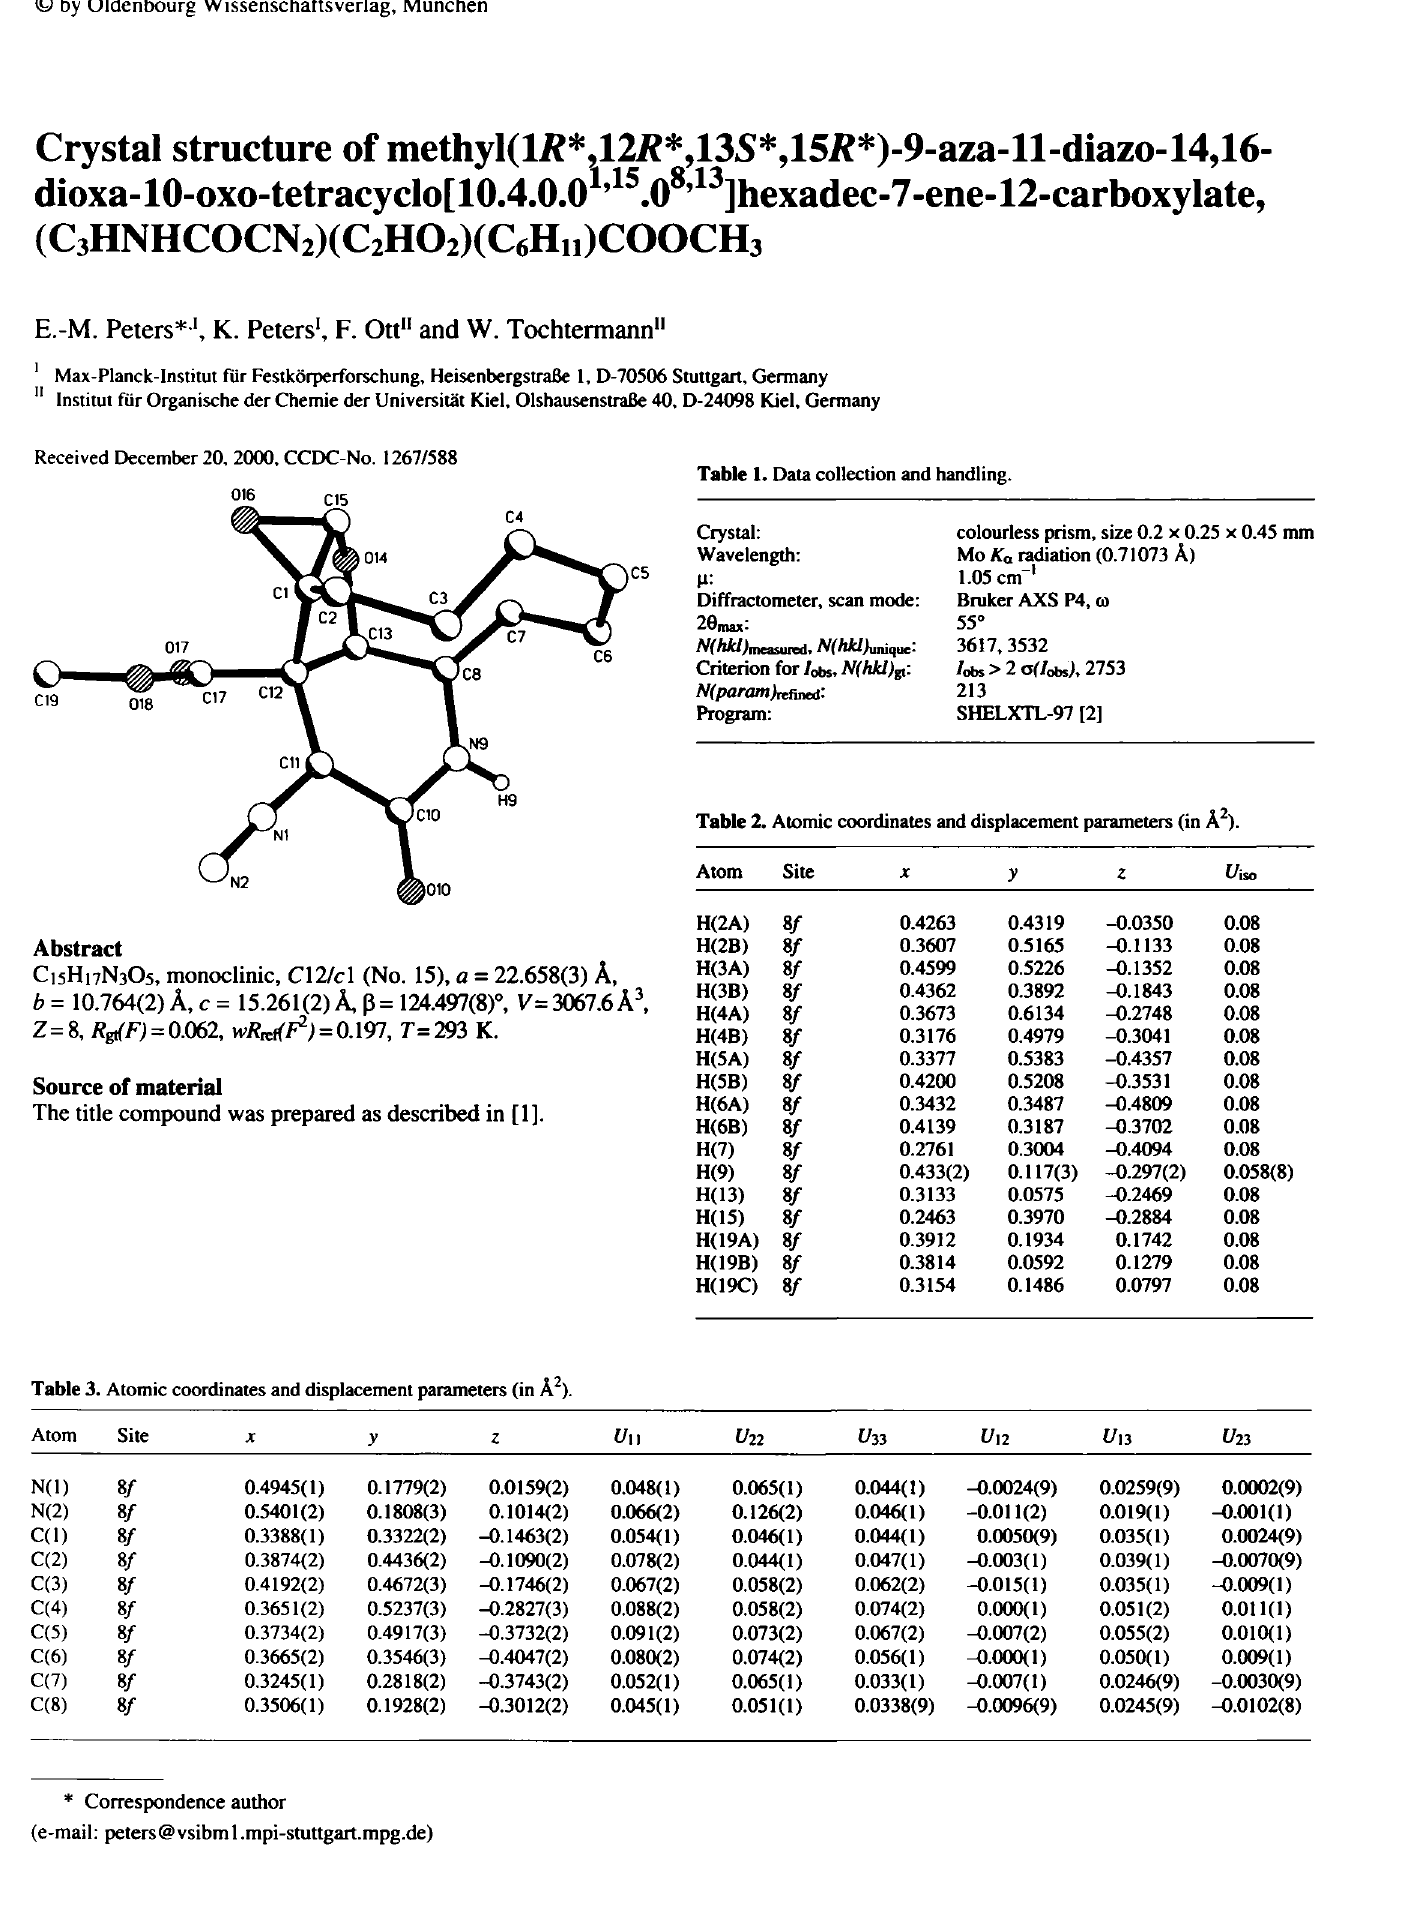
Table 3. Atomic coordinates and displacement parameters (in Ä 2